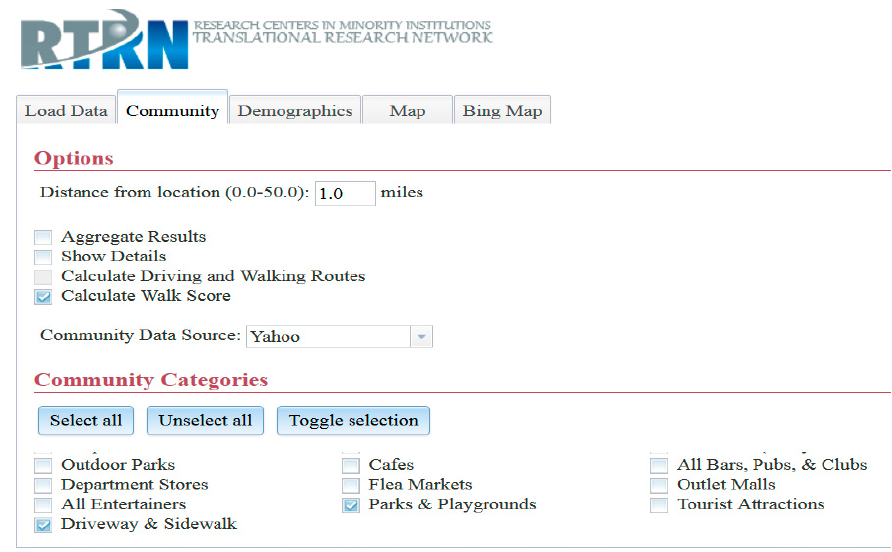
Figure 2. Screen capture for data input screen.